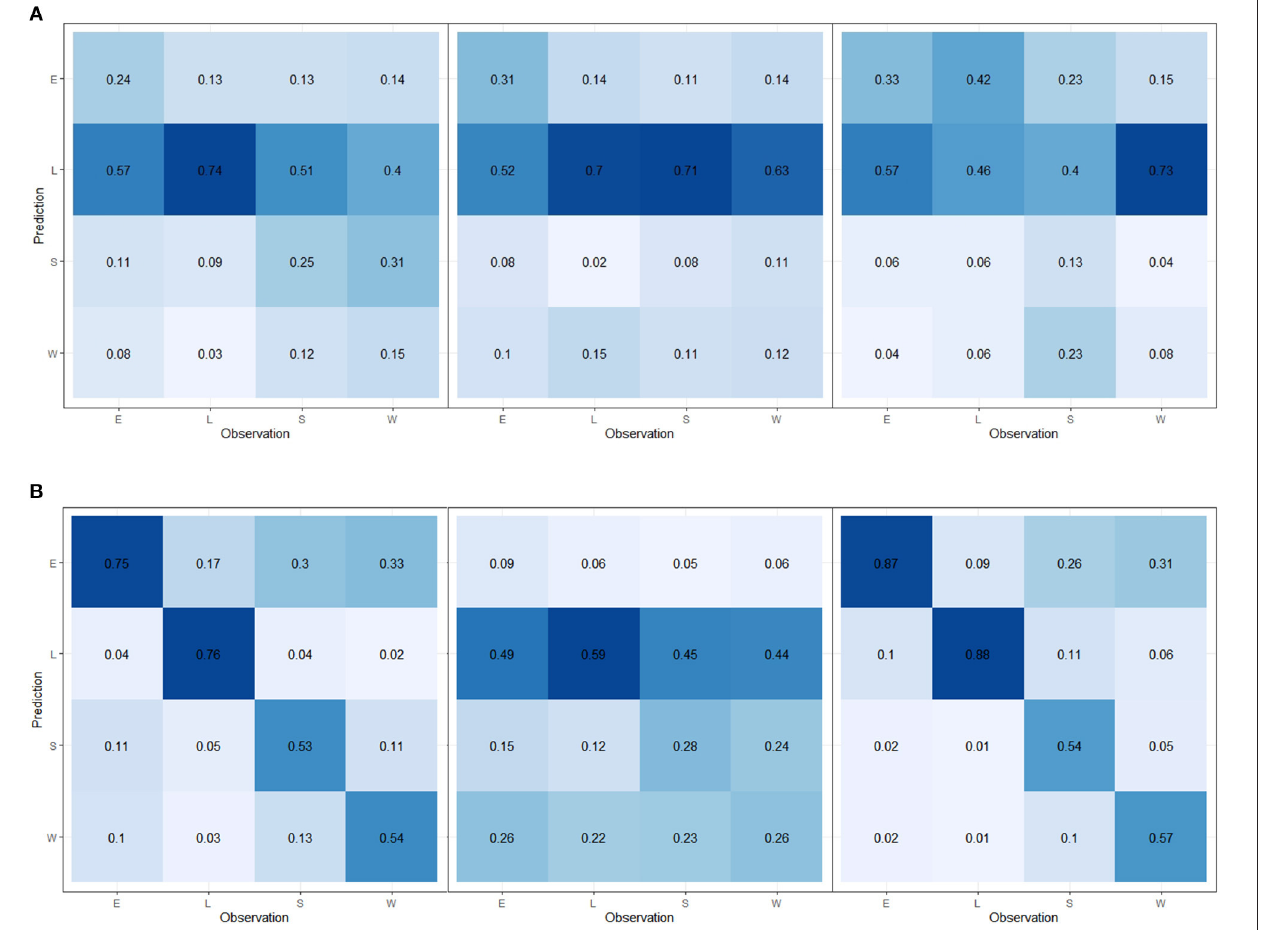
FIGURE 3 | Normalized confusion matrix of behavior classification from the per-pig cross-validation after using Wavelet filtering and under-sampling (A) . Left: tested on pig A. Middle: tested on pig B. Right: tested on pig C. Normalized confusion matrix of behavior classification from the per-pig cross-validation after data augmentation with BL-SMOTE and Wavelet filtering (B) . Left: tested on pig A. Middle: tested on pig B. Right: tested on pig C.